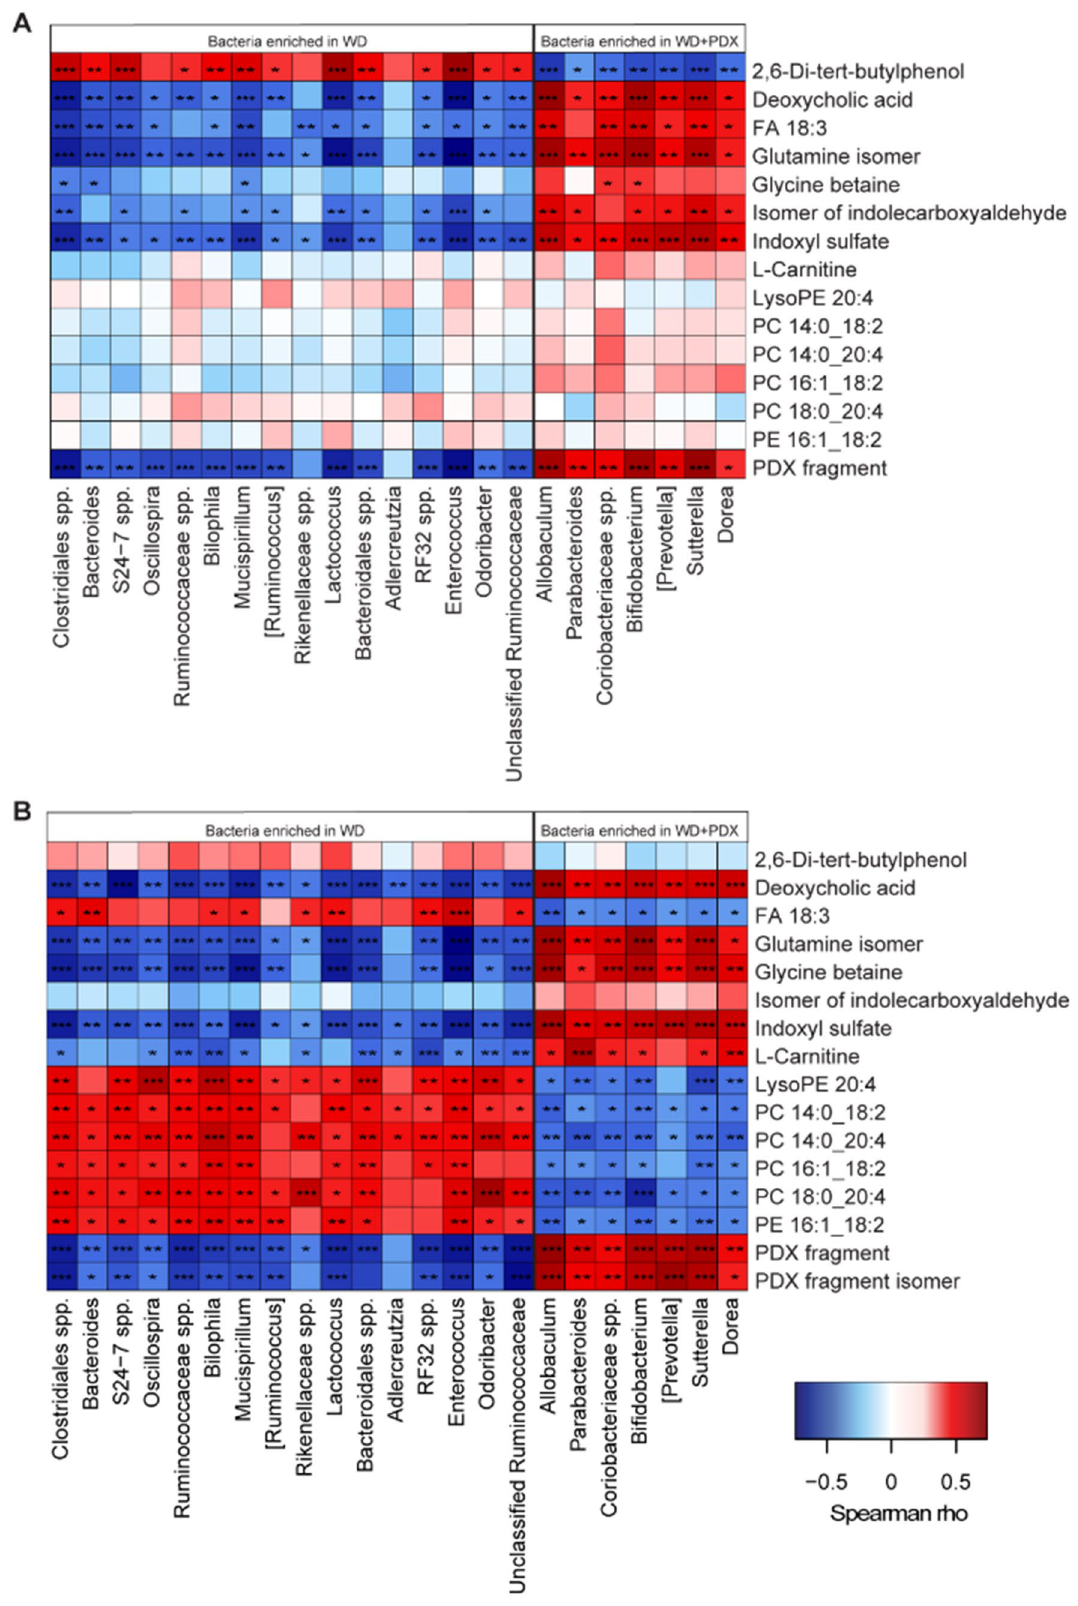
Figure 4. Heatmap showing the correlations among the relative abundance of cecal bacteria, at the genus level, and the metabolites identified in ( A ) adipose and ( B ) plasma. Bacteria are ordered by those that were enriched in the control Western diet (WD)-fed mice or in the WD diet-fed mice administered polydextrose (PDX). *** p < 0.001, ** p < 0.01, * p <